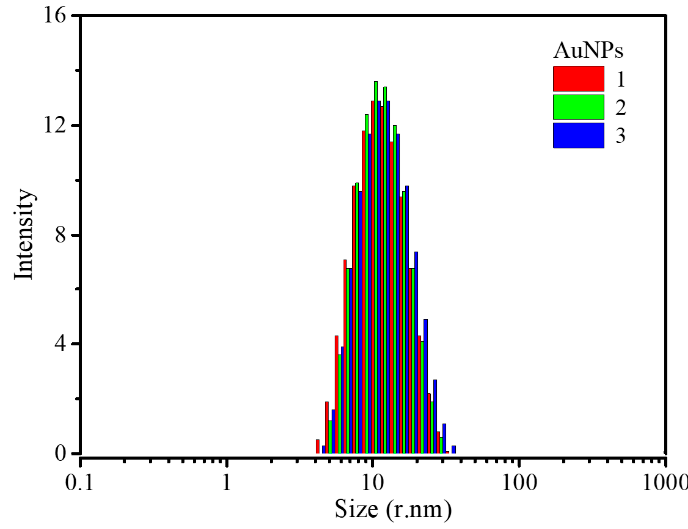
Figure 11. Size-distribution histogram with triplicate measurement for AuNPs using DLS. The z-average for the colloidal nanoparticles was measured as 20.26 with 13.76 diameters and a 0.27 polydispersity index (w1qaPdI). Even distribution of the AuNPs at 13 nm size (Table 1). The zeta potential of the diluted AuNPs was − 17.66 mV with 1.05 mS/cm conductivity. Table 1. Measurements for the dynamic light scattering and zeta potential in triplicate for AuNPs. AuNPs Z-Average (r. nm) D(i,10) PdI Conductivity (mS/cm) Zeta Potential (mV) 2 1 20.31 13.5 0.273 0.953 − 17.4 2 2 20.29 14 0.271 1.09 − 19.4 2 3 20.18 13.8 0.266 1.13 − 16.2